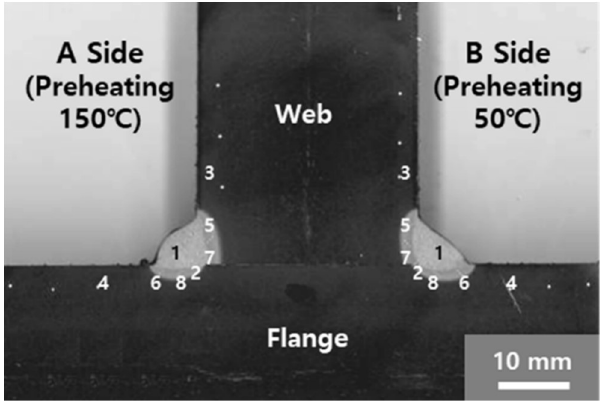
Figure 11. Hardness measurement positions of the welded double-fillet T-joint of the 30 mm thick plate.